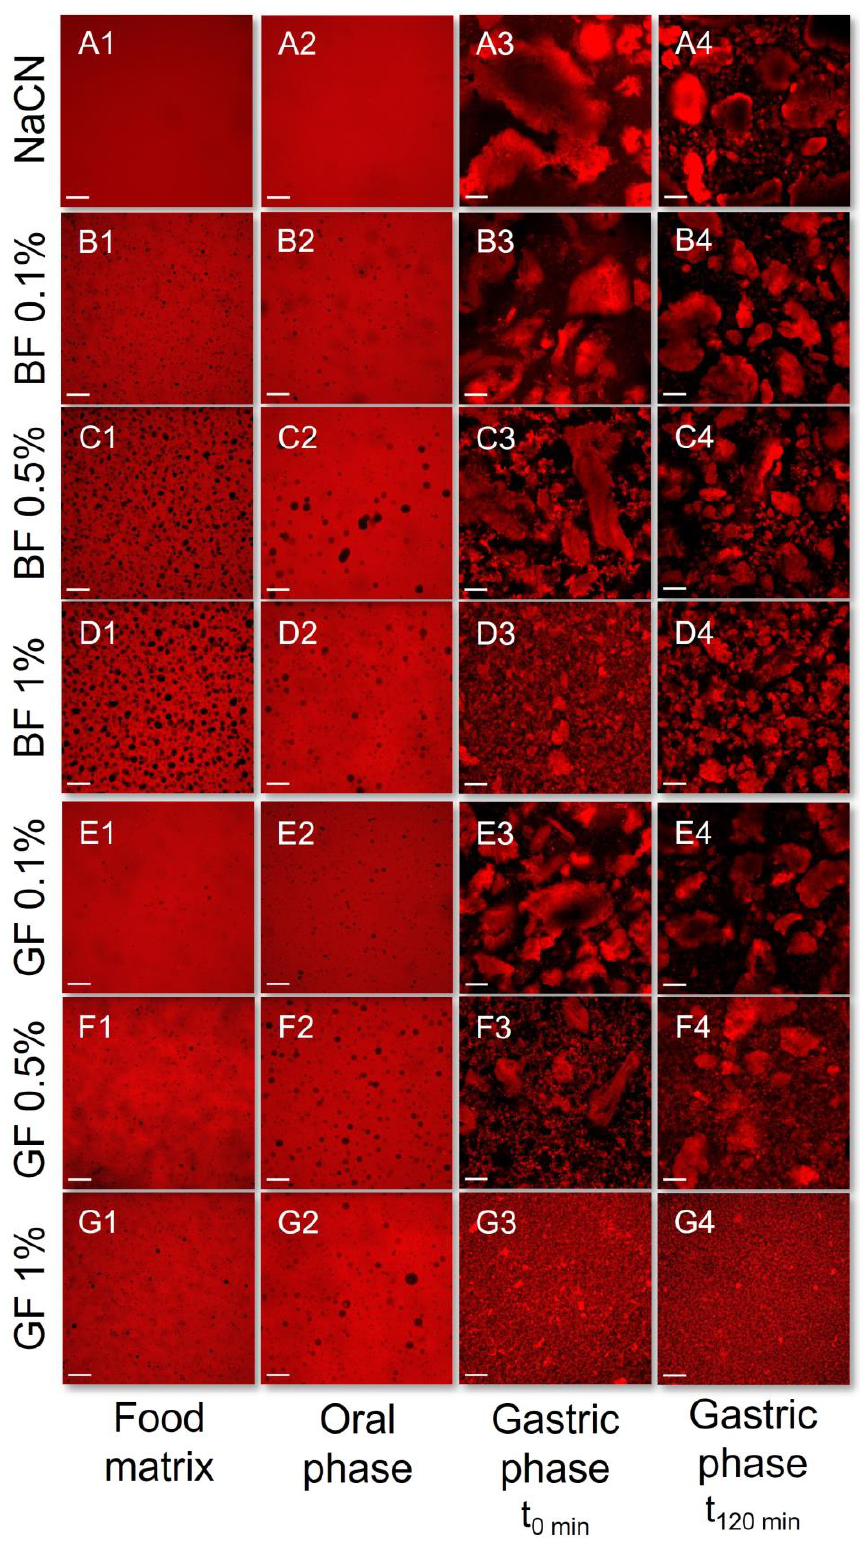
Figure 3. CLSM assessment of the impact of flaxseed gums on the in vitro oro-gastric induced col- loidal changes of the NaCN-based food models adopting the INFOGEST 2.0 in vitro digestion model. 1 : Food matrix, 2 : Oral phase; 3 : gastric (start); 4 : gastric (end); ( A ): NaCN only; ( B – D ): NaCN + BF; ( E – G ): NaCN + GF. Scale bar = 100 µm.